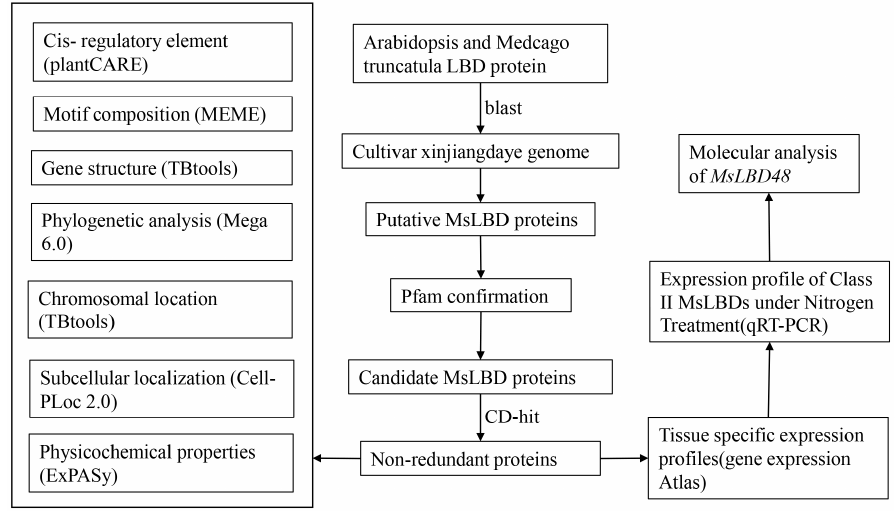
Figure 1. The framework of content in this study.